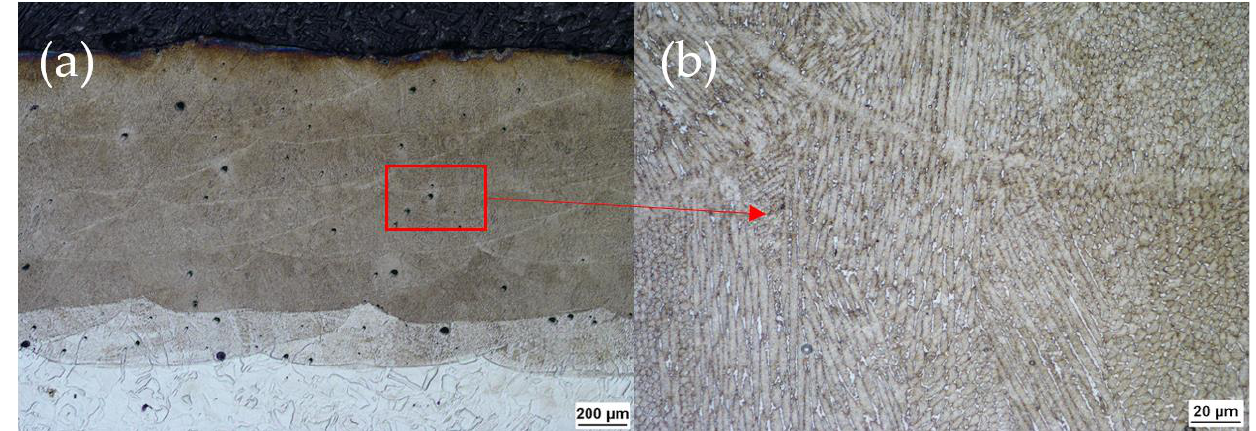
Figure 11. Optical micrograph of the interface zone in specimen 5_T at 200X magnification.